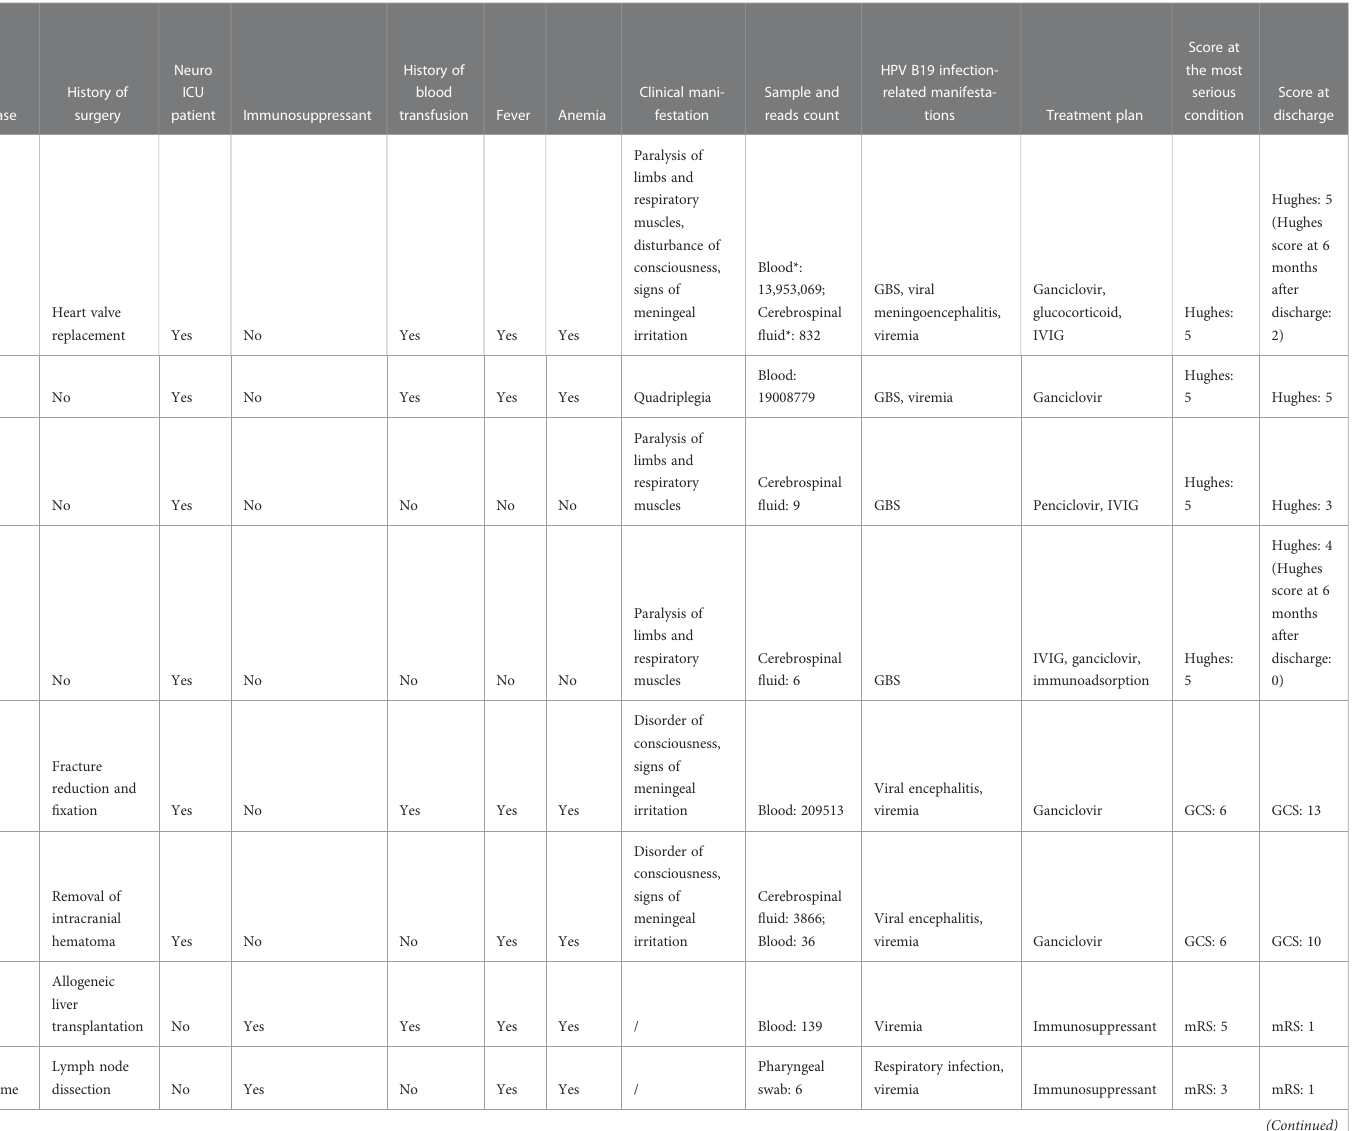
TABLE 1 Clinical data of patients infected with human parvovirus B19. Patient